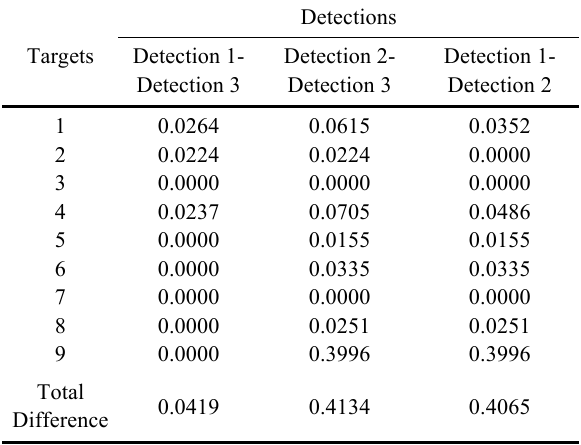
Comparison between the different coordinates computations of the nine fixed targets. Coordinates computed three different ways: Detection 1 (t1, t2, min duration), Detection 2 (t1,